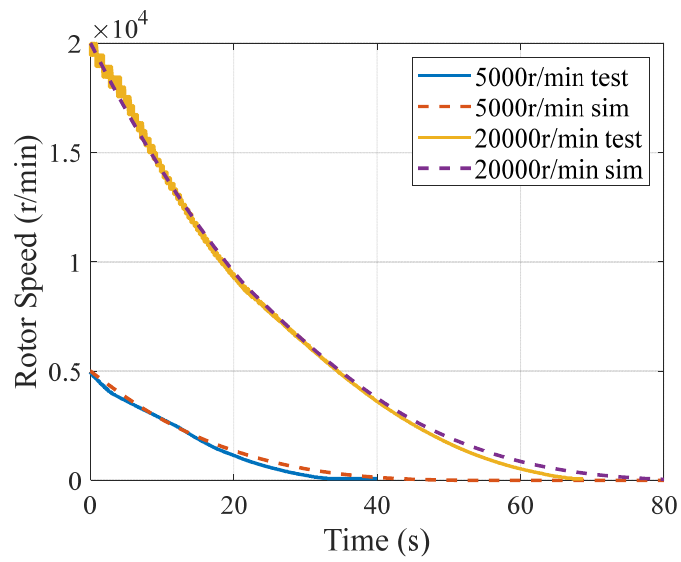
Figure 14. Comparison of rotor speed changes between simulation and experiment.